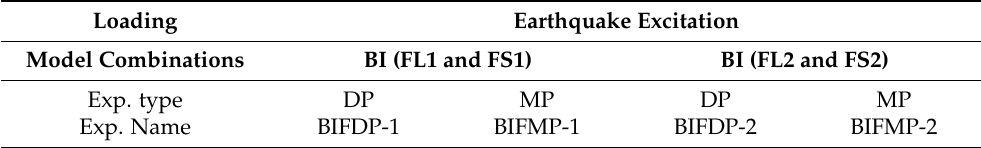
Table 3. Experiments of flexible base-isolated models.